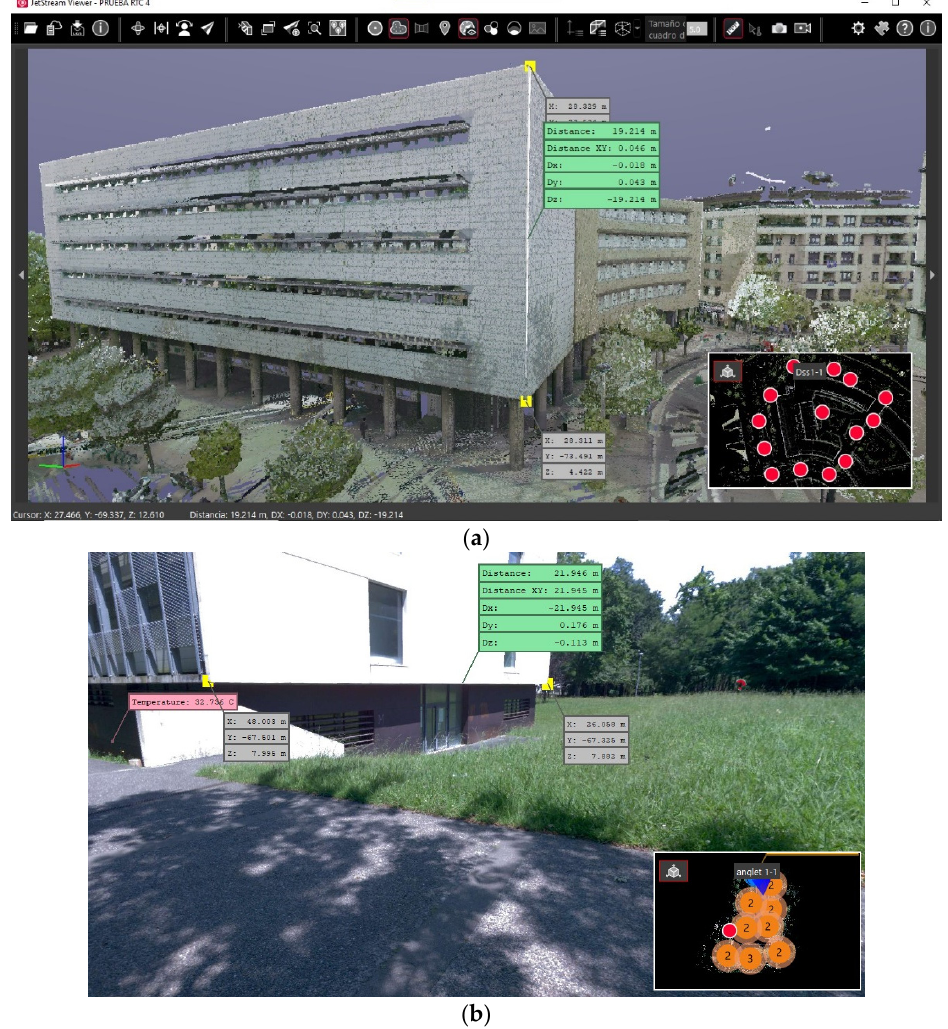
Figure 17. Visualization of results of the TLS LiDAR clouds in Jetstream Viewer, obtaining quantitative data for the model: ( a ) 3D colored cloud visualization, geometric data, Gipuzkoa School of Engineering building, UPV/EHU campus in DSS; ( b ) southwest façade of the same building. Visualization from the 360° image of the building, geometric data (green and gray) and thermal data (red).